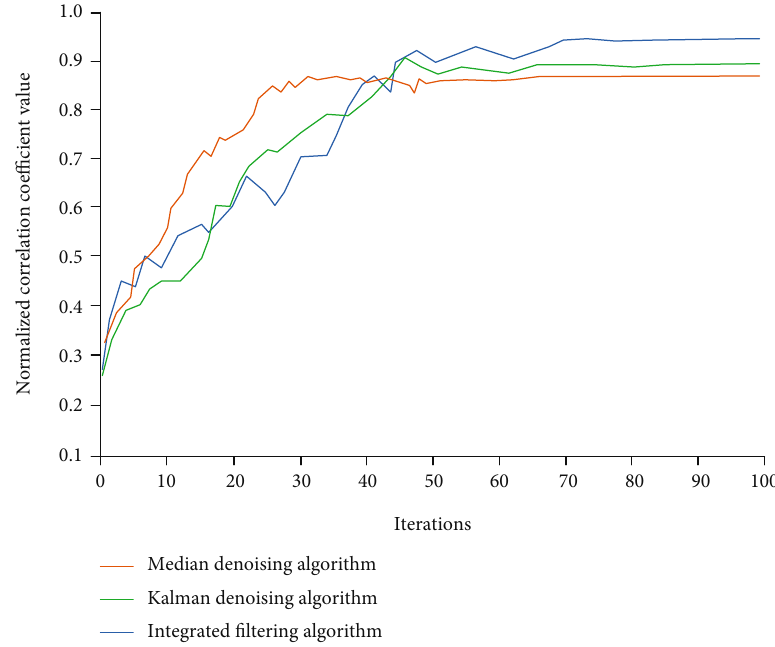
Figure 6: Statistical results of correlation coe ffi cients of each fi ltering